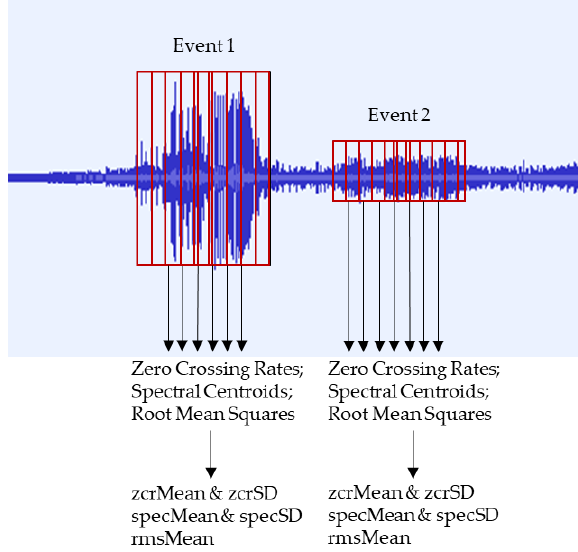
Figure 2. Extraction of the zero-crossing rate (zcrMean), standard deviation of zero-crossing rate (zcrSD), mean of spectral centroid (specMean), standard deviation of spectral centroid (specSD), and mean of root mean square (rmsMean), with 2048 samples each and a hop length of 512